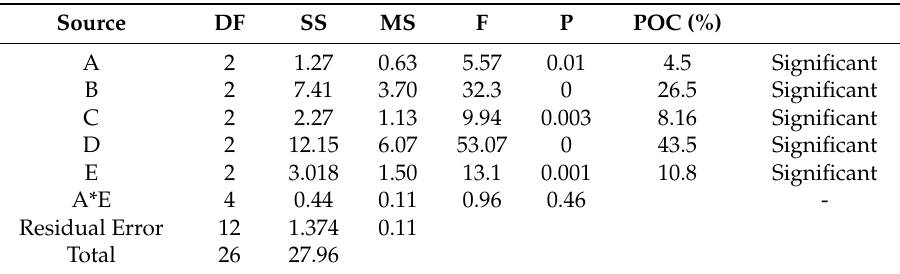
Table 5. ANOVA for surface roughness.